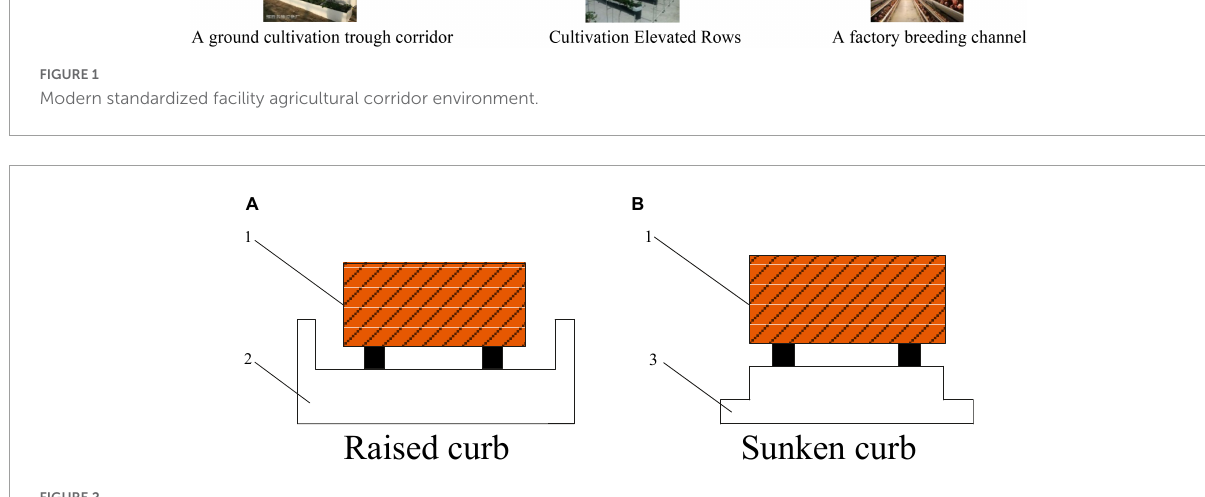
FIGURE2 Characteristics of two types of curbs: (1) An autonomous moving platform, (2) A raised curb, and (3) A sinking curb.